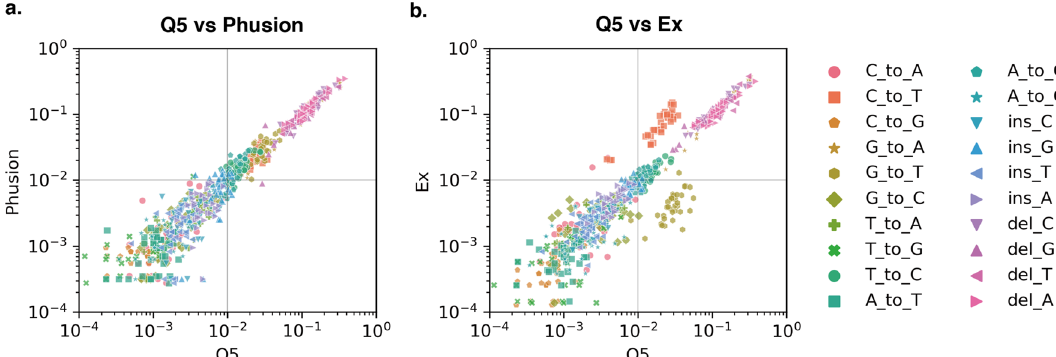
Figure 4. Comparison of error rates derived from assembling reactions using different polymerases. The synthesized oligonucleotide in the same batch was split into three samples and prepared NGS library by using